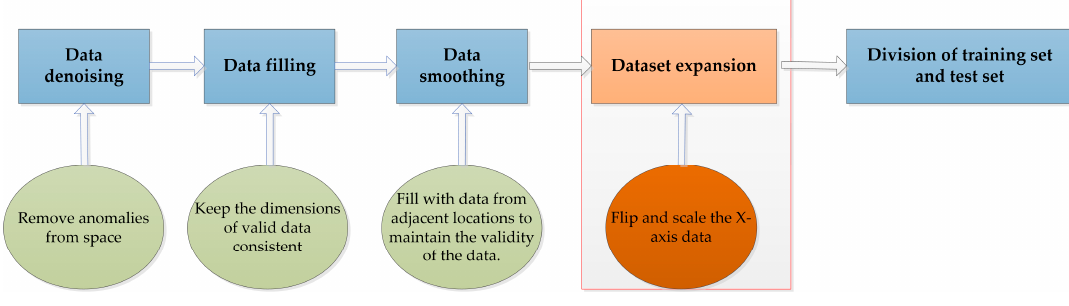
Figure 7. Flow of data processing.